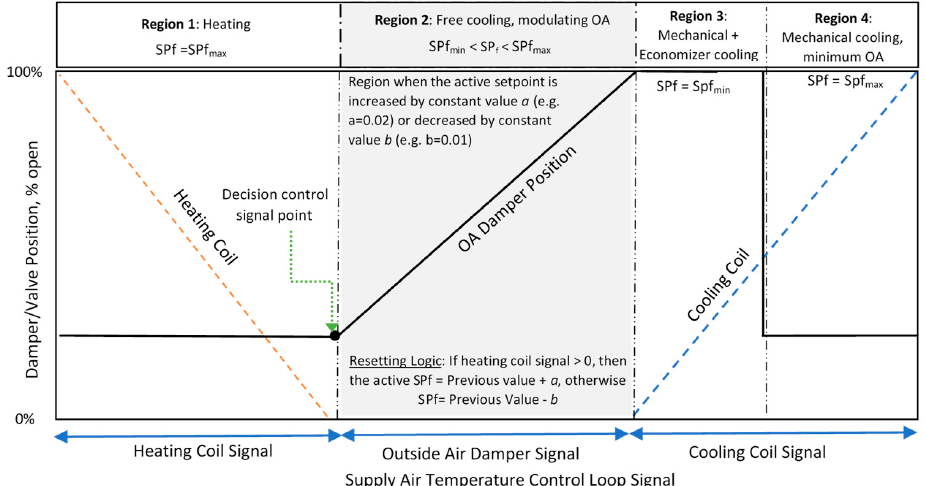
Figure 2. AHU operating states and the recommended minimum zone airflow setpoint (SPf) strat- egy.